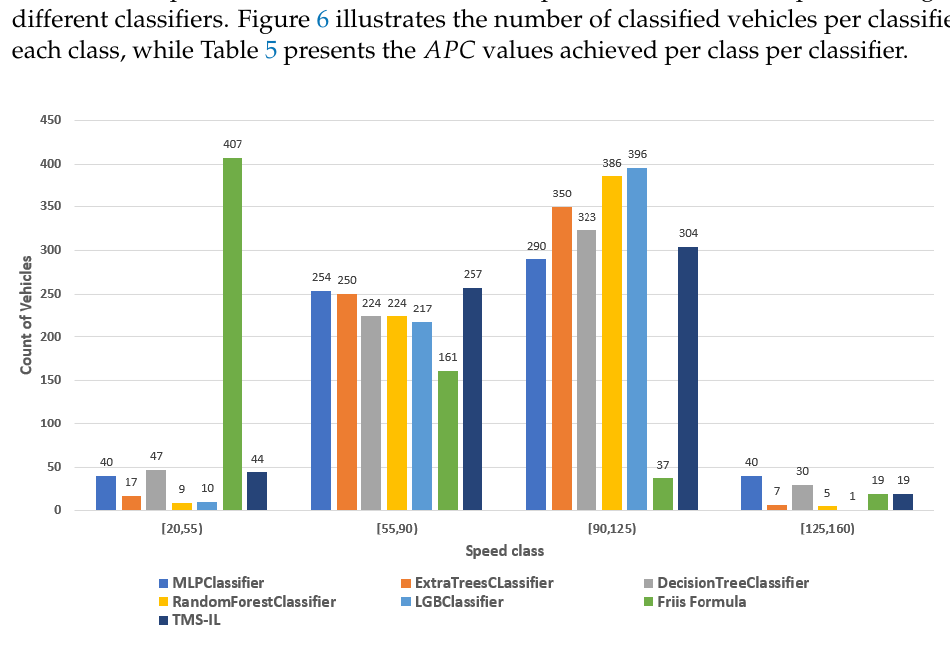
Figure 6. The 4-classes vehicle count per class over TMS-IL count per